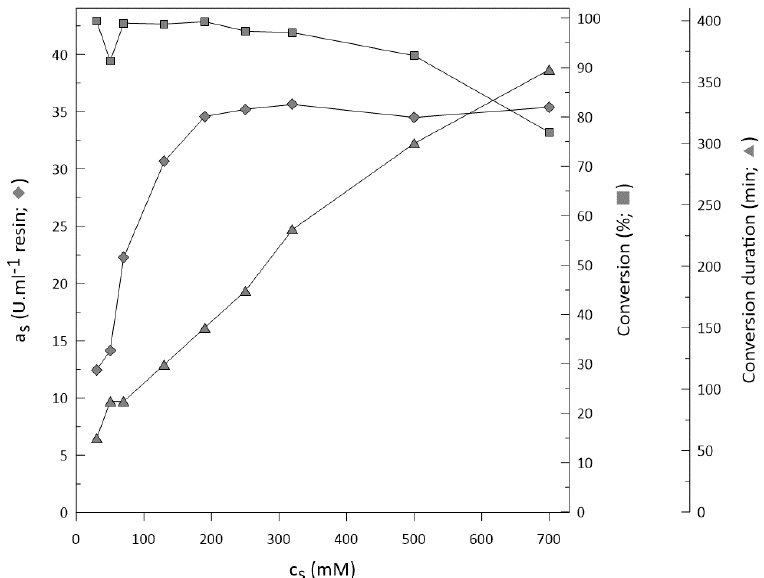
Figure 7. Initial activity, substrate conversion, and time needed for completion of each conversion with different substrate concentrations.